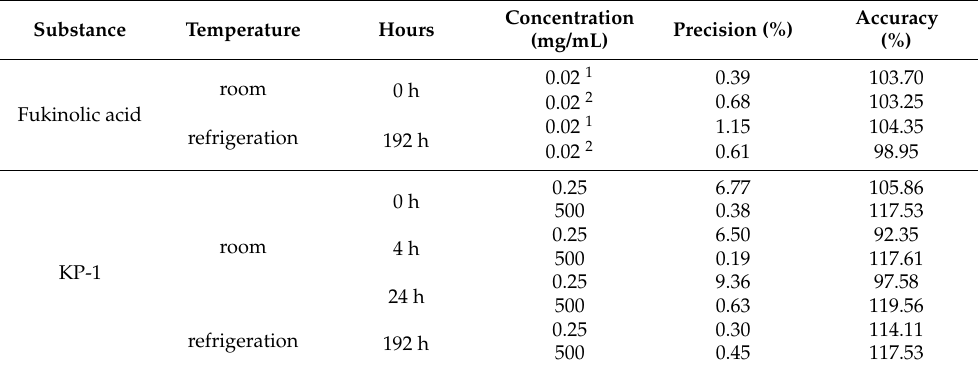
Table 2. Stability of Fukinolic acid and